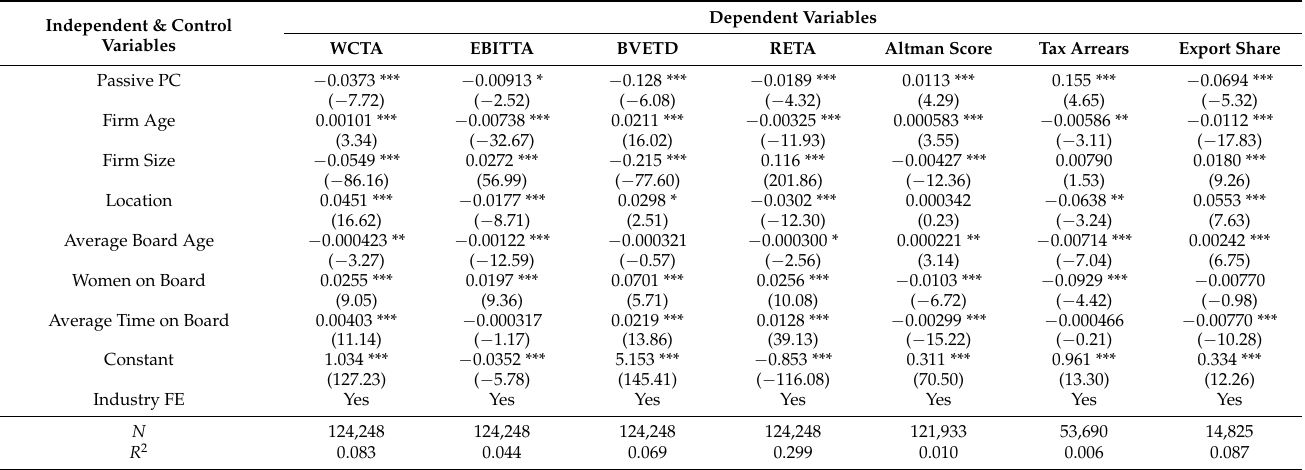
Table 2. OLS regressions with seven different dependent variables (from year 2019) and Passive PC as the independent